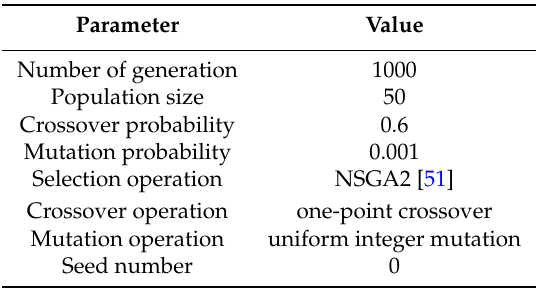
Table 1. Evolutionary Algorithm (EA)